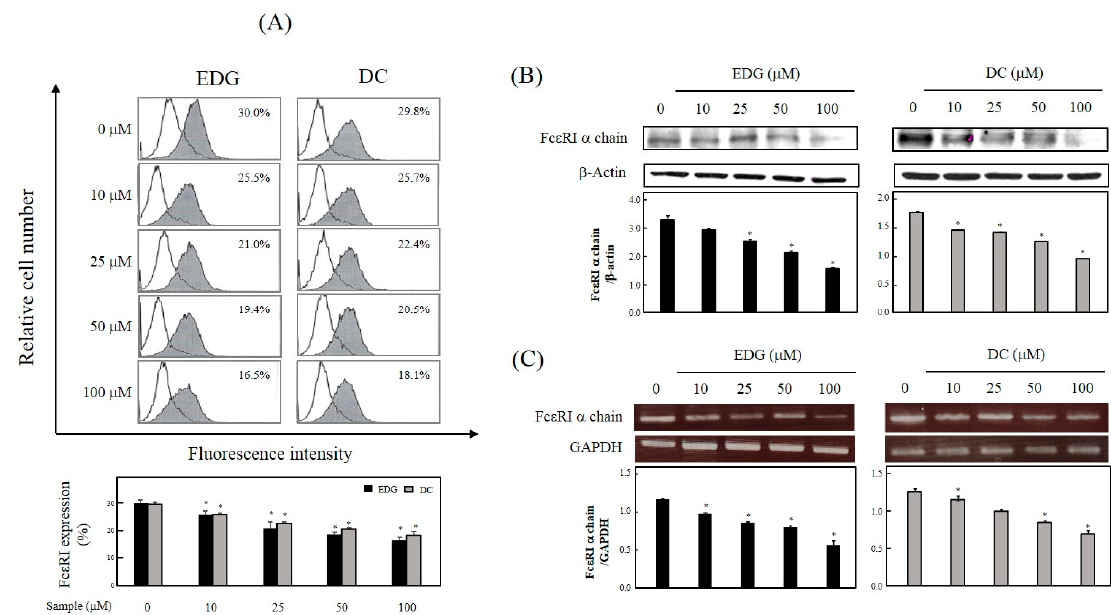
Figure 3. E ff ects of EDG and DC on Fc ε RI expression. KU812F cells were cultured in the presence of Figure 3. Effects of EDG and DC on Fc ε RI expression. KU812F cells were cultured in the di ff erent EDG and DC concentrations (0, 10, 25, 50, and 100 µ M) for 24 h under serumfree conditions. presence of different EDG and DC concentrations (0, 10, 25, 50, and 100 µM) for 24 h under ( A ) Flow-cytometry analysis conducted using anti-Fc ε RI antibody (CRA-1) followed by staining serumfree conditions. ( A ) Flow-cytometry analysis conducted using anti-Fc ε RI antibody with fluorescein isothiocyanate (FITC)-conjugated Fragment antigen binding, F(ab’) 2 goat antimouse immunoglobulins. ( B ) Western blot analysis conducted using CRA-1 and β -actin. Protein amount in each band was quantified by densitometry. ( C ) Total RNA was prepared, and Fc ε RI α chain and internal control, glyceraldehyde 3-phosphate dehydrogenase (GAPDH) were detected by RT-PCR. Each value represents mean ± SD of three di ff erent experiments. Relative density calculated as ratio of each protein expression to β -actin and each mRNA level to GAPDH. * Values significantly di ff erent from control (* p <